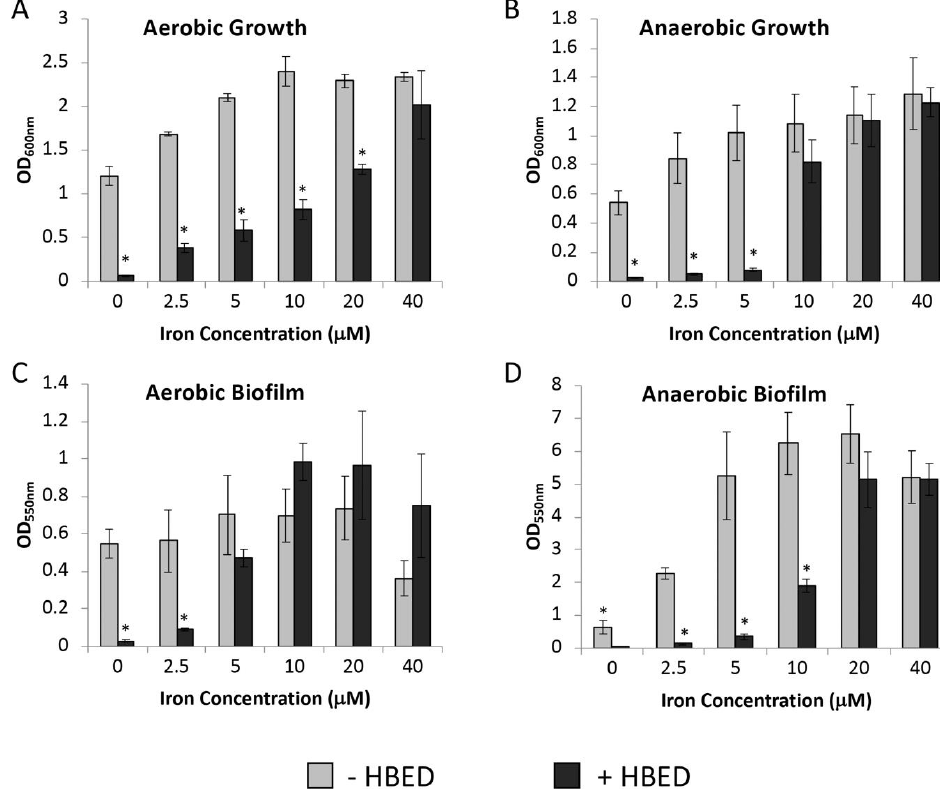
Figure 2. E ff ect of supplemental iron on growth and biofilm formation of PAO1 in the presence of N,N’-bis (2-hydroxybenzyl) ethylenediamine-N,N’-diacetic acid (HBED). Values shown represent the mean level of ( A , B ) growth and ( C , D ) biofilm formation +/ − standard error of the mean (SEM) of the P. aeruginosa strain PAO1 in succinate medium with FeCl 3 supplemented at concentrations indicated in the presence and absence of HBED (25 µ M in aerobic conditions, 10 µ M in anaerobic conditions). Growth was under aerobic (a, c) and anaerobic (b, d) conditions. * denotes significantly di ff erent values compared to no HBED determined using Student’s t -test ( P <